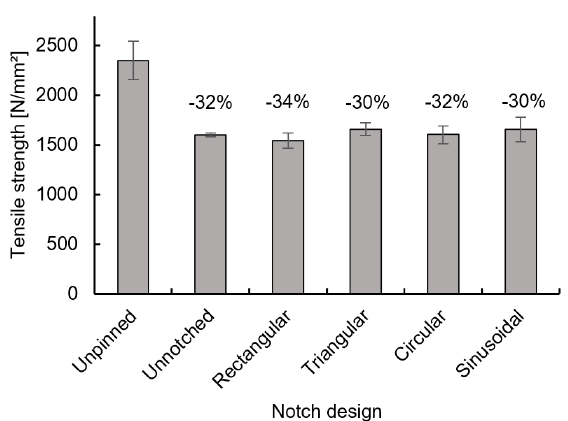
Figure 6. Tensile strength values and standard deviation values of unidirectional carbon-fibre reinforced composite laminates reinforced with unnotched z-pins as well as with circumferentially notched z-pins with different notch designs at constant notch depth of 20 µ m and notch distance of 100 µ m, in comparison to unpinned